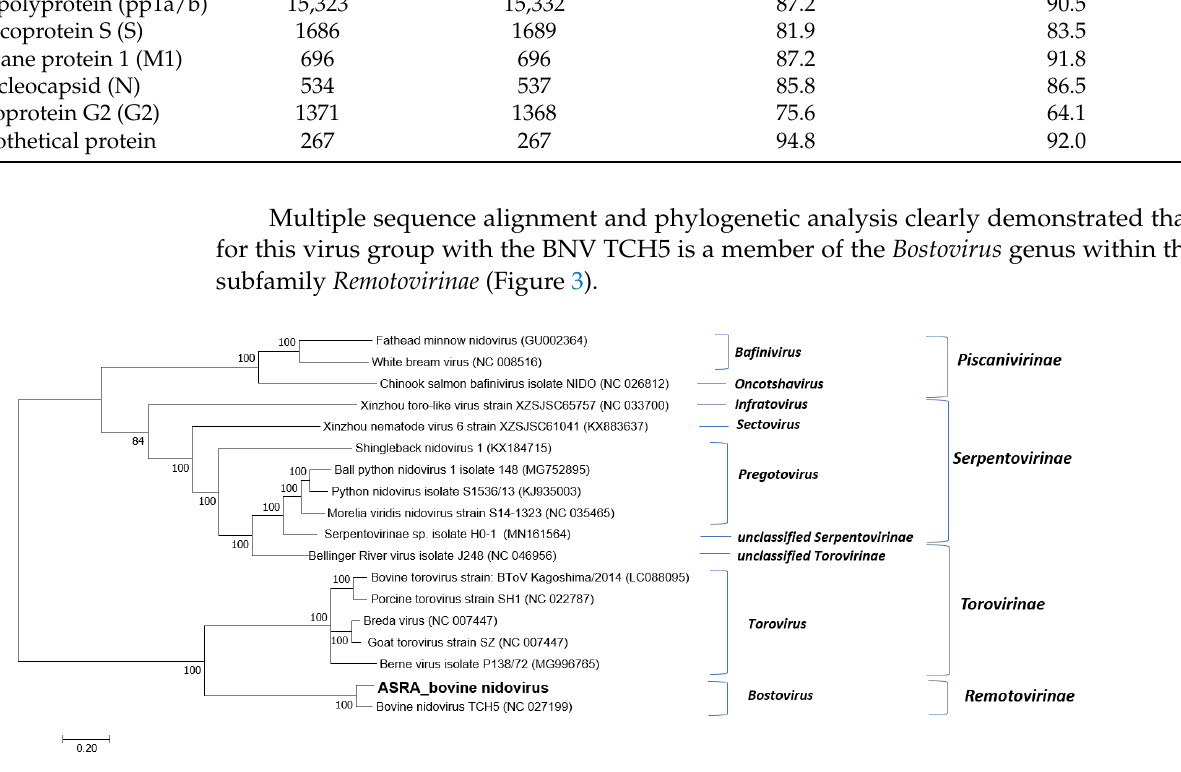
Figure 3. Phylogenetic tree of the family Tobaniviridae based on the replicase polyprotein (pp1a/b) gene. The phylogenetic tree was constructed using the maximum likelihood method based on the general time reversible model. Bootstrapping of 500 replicates was performed. Phylogenetic analysis of the predicted nucleotide sequences determined in this study. In order to determine the best DNA model to use for phylogenetic analysis, model selection was performed, which analysed the maximum likelihood fits of 24 different nucleotide substitution models. The trees are drawn to scale, with the scale bar representing the number of nucleotide substitutions per site. Numbers at nodes represent percentage bootstrap support (values are indicated for each node >50%). The Australian sequences from this study are shown in bold. The isolate names and GenBank accession numbers for the sequences used in the trees are